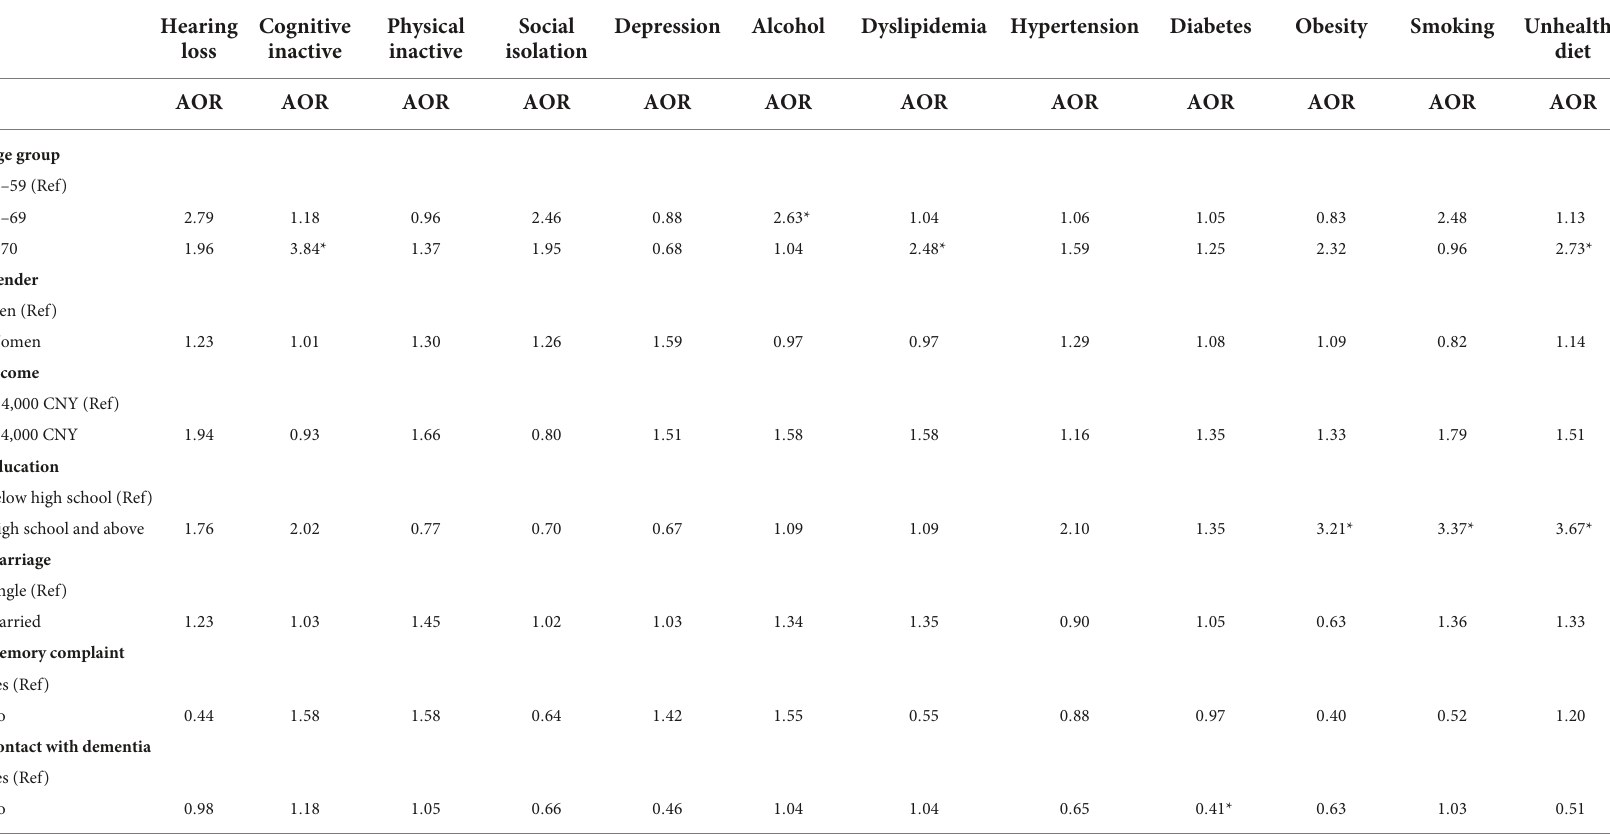
TABLE 3 Socio-demographic factors associated with knowledge of dementia risk